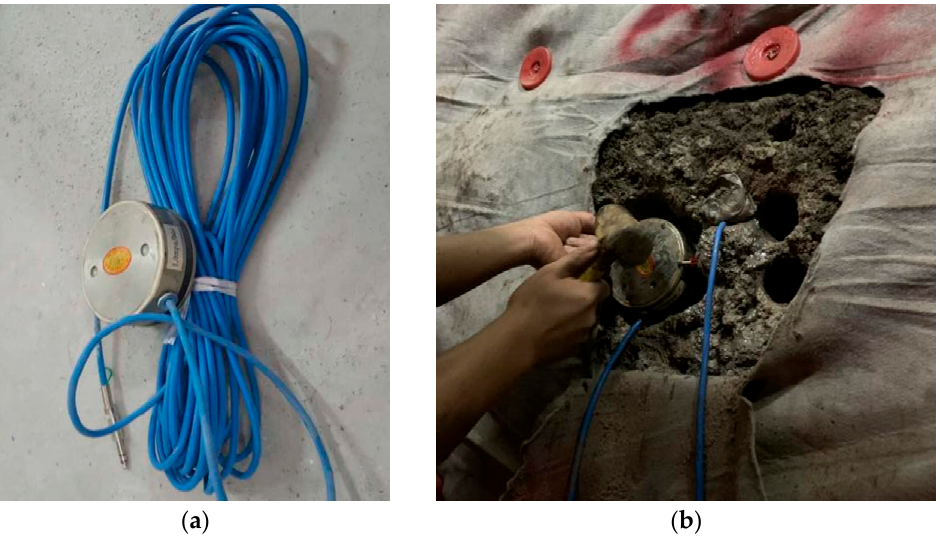
Figure 13. Field installation of contact pressure sensor: ( a ) earth pressure cell; ( b ) instrument instal ‐ lation.